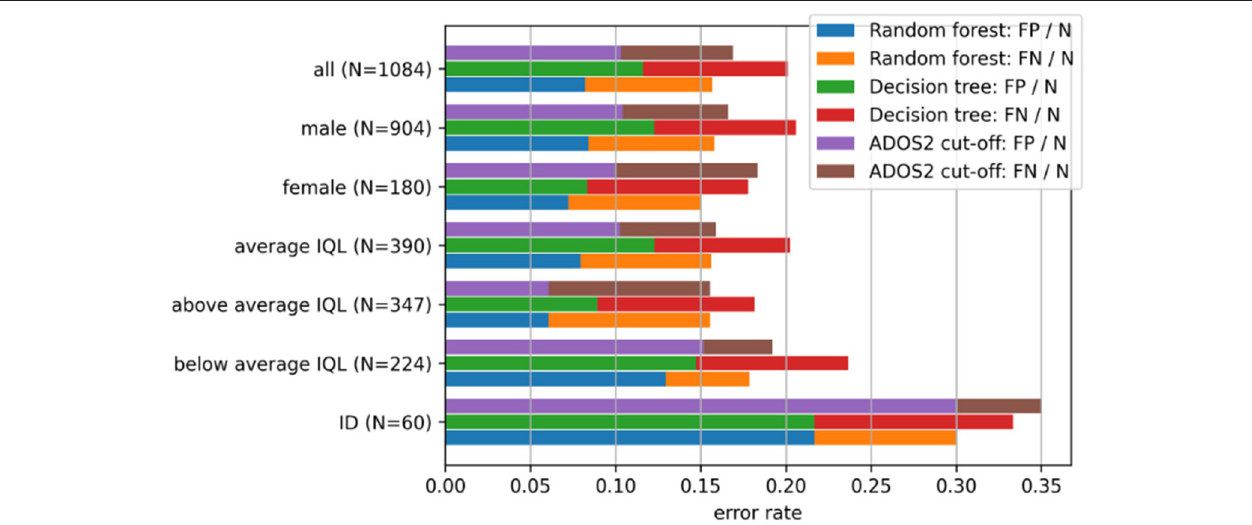
FIGURE 2 | Comparison of error rates and their composition of false negatives (FN) and false positives (FP) by several sub-cohorts (e.g. sex-specific). For the calculation of the error rates of the respective algorithm [random forest (RF), decision tree (DT), ADOS/2] per sub-cohort, FN and FP are divided through the respective sample size N of the sub-cohort. IQL, IQ